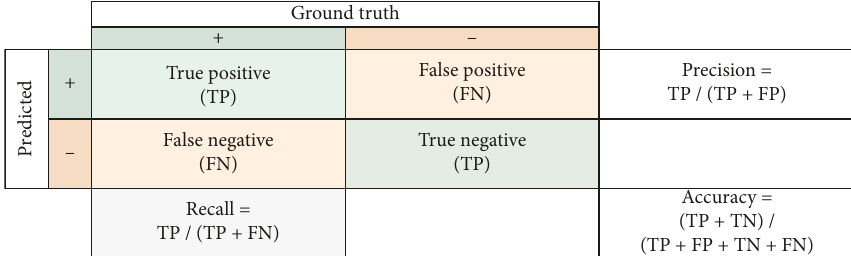
Figure 3: Confusion matrix and performance criteria of classification